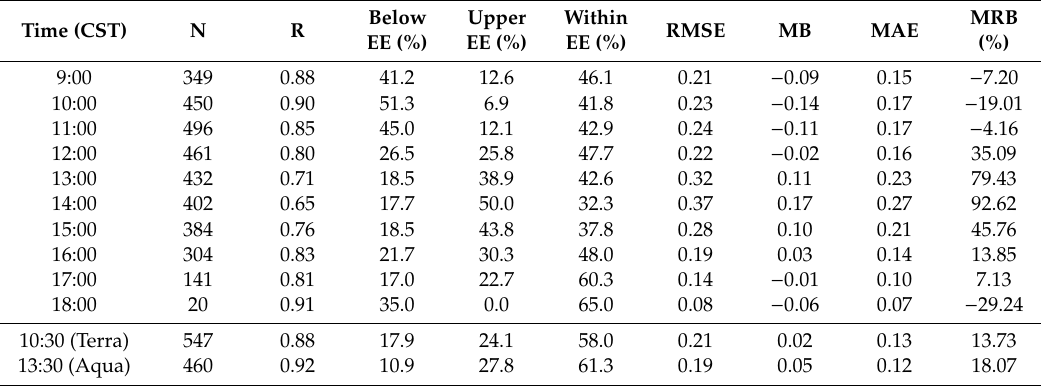
Table 4. Hourly comparison of AHI and AERONET AOD at 500 nm in China for 09:0–18:00 (CST) and MODIS against AERONET for 10:30 (Terra) and 13:30